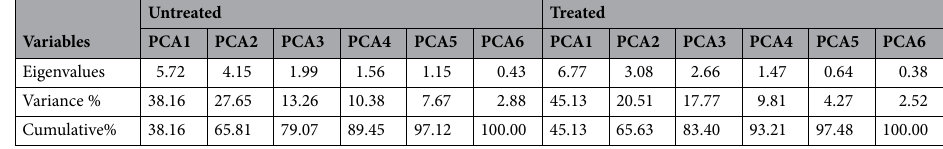
might be unobservable for Ajwa , Maghol , and Khadari varieties. The results indicated that, no significant dif- ference in the total color difference between treated and untreated palm date varieties. Similarly, no significant